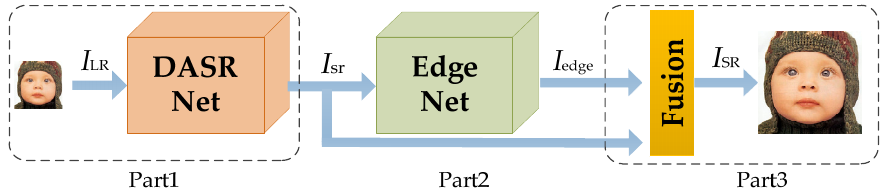
Figure 1. Our proposed enhanced feedback attention image super-resolution network (EFANSR) framework comprises three parts: a dense attention super-resolution network (DASRNet), EdgeNet, and Fusion.